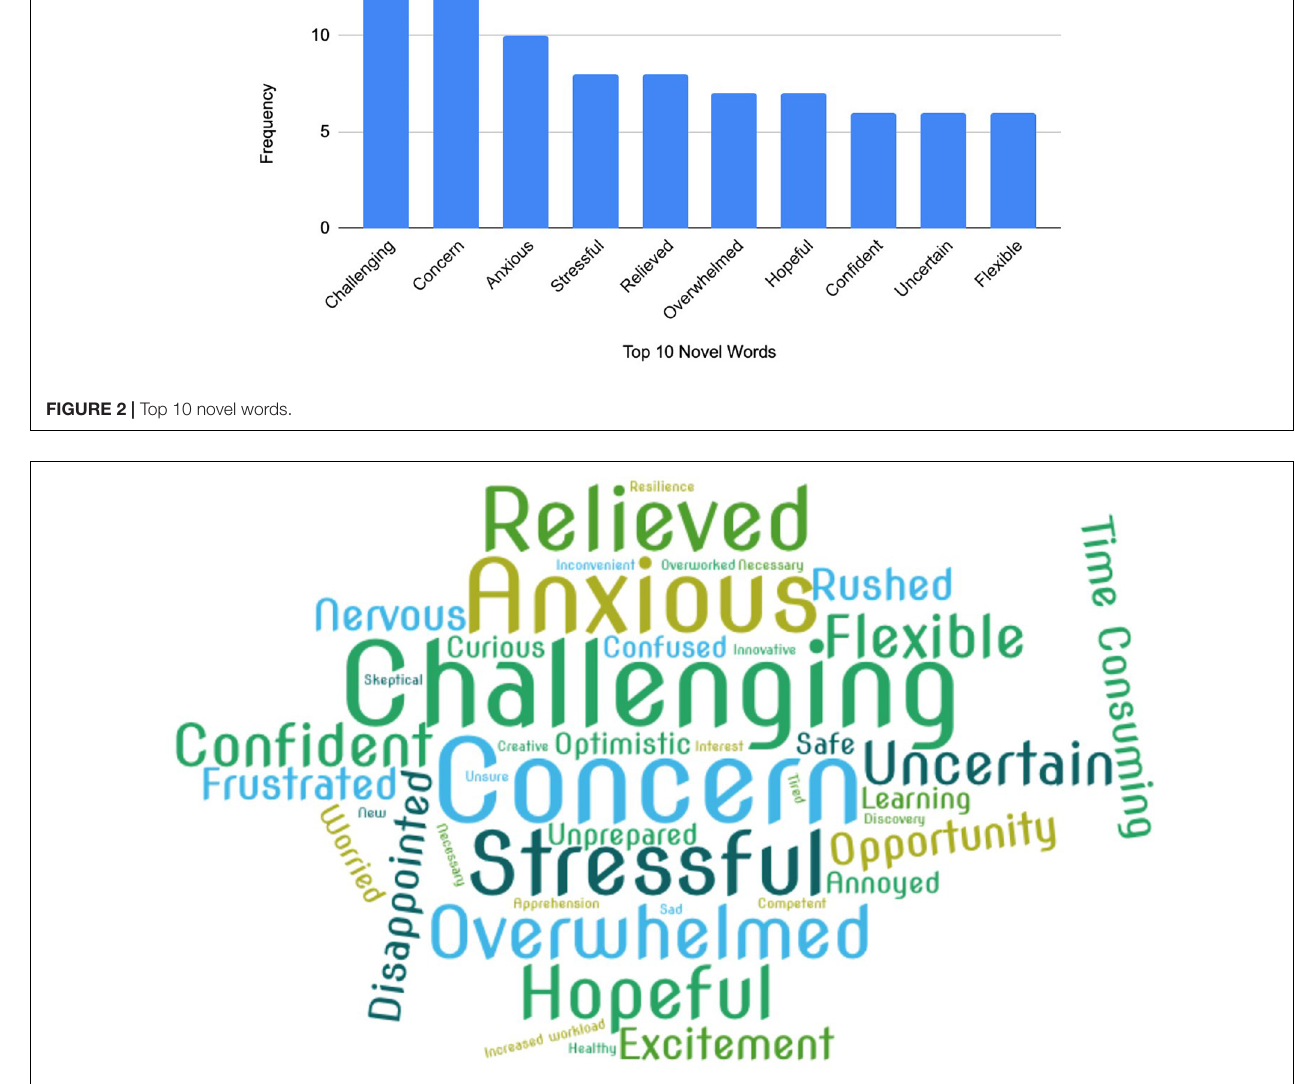
FIGURE 3 | Word cloud of most frequently used words across